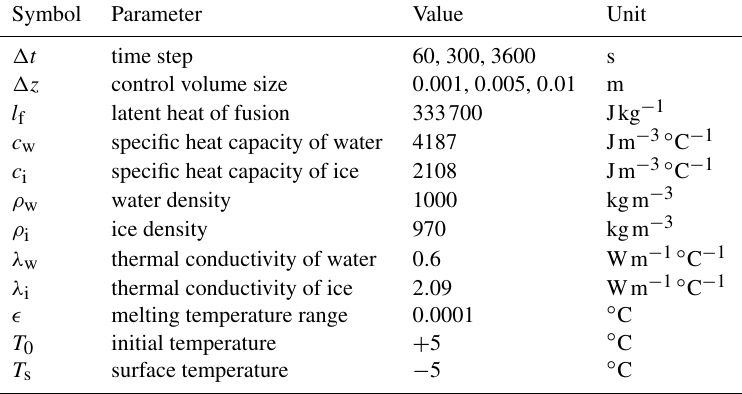
for the fully thawed and frozen conditions respectively.